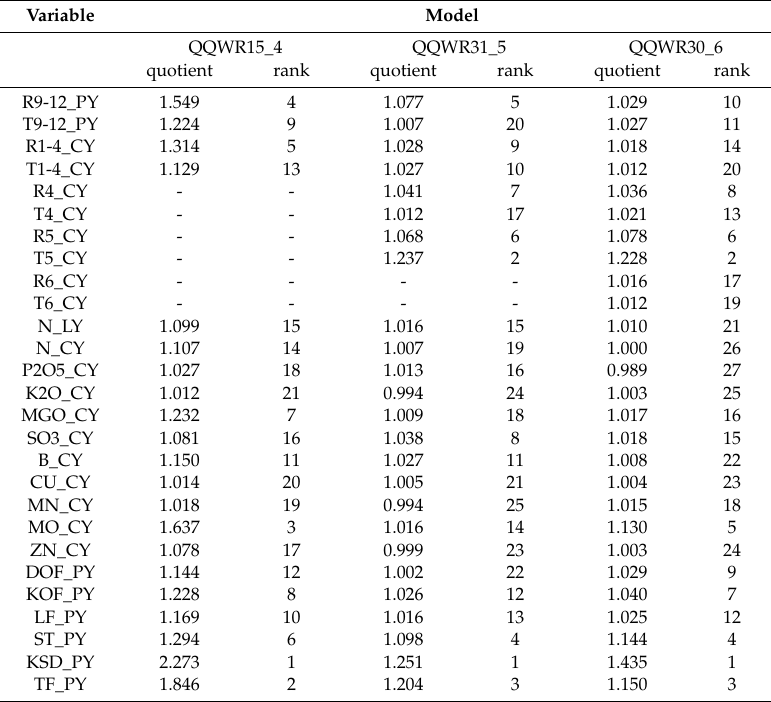
Table 5. Sensitivity analysis of neural